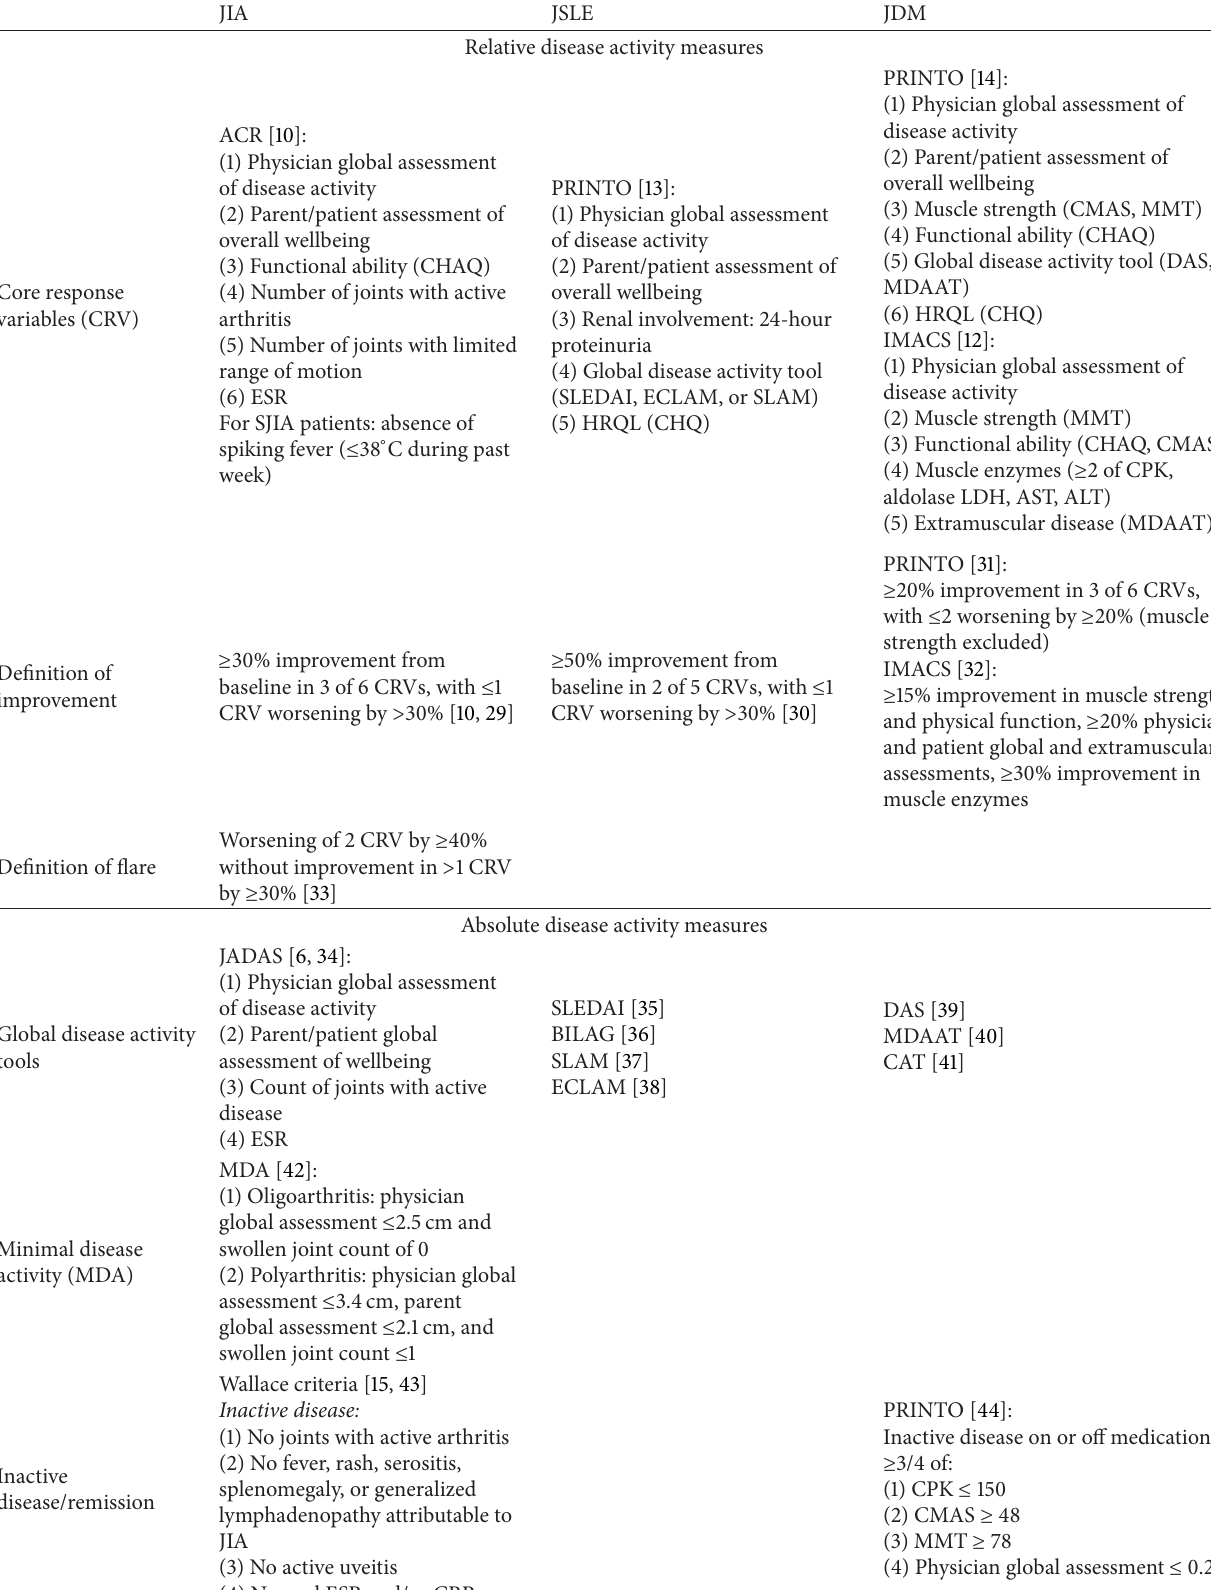
Table 3: Summary of disease activity measures for juvenile idiopathic arthritis (JIA), juvenile systemic lupus erythematosus (JSLE), and juvenile dermatomyositis (JDM). JIA JSLE